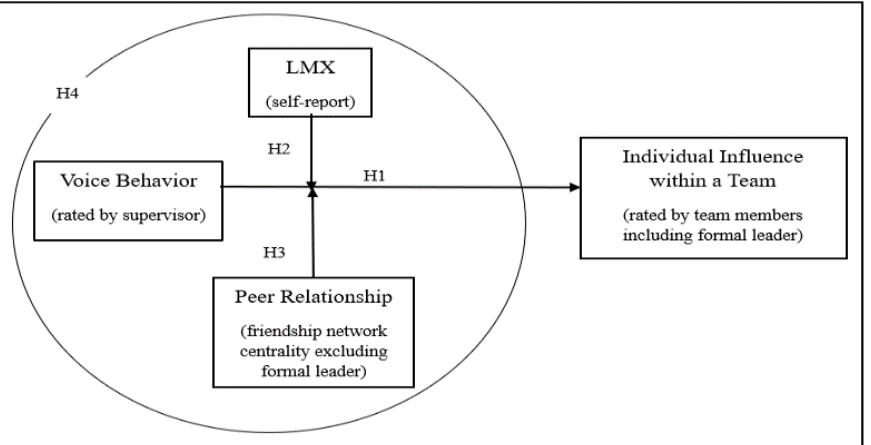
Figure 1. Research